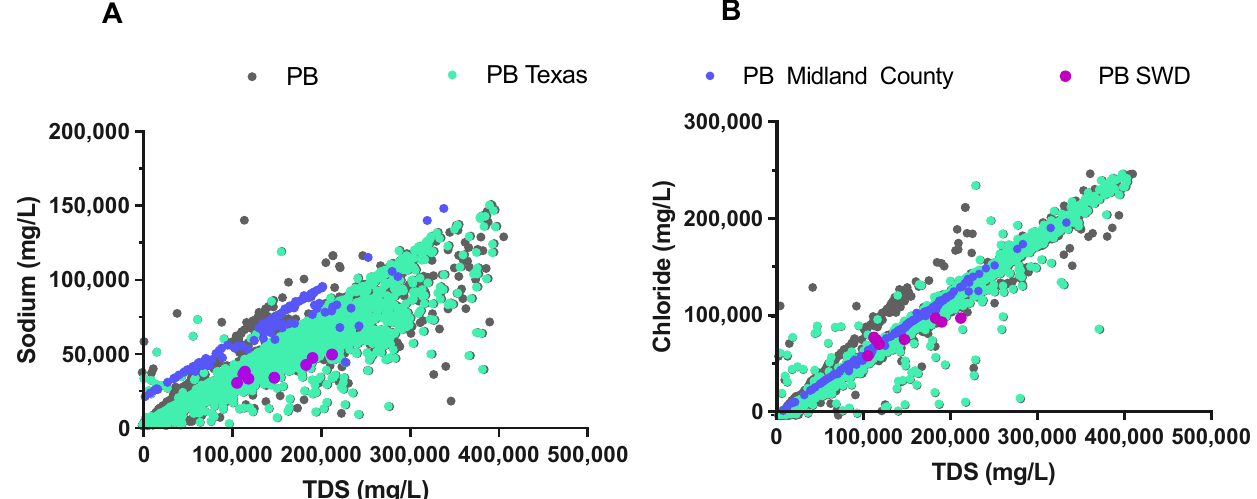
Figure 8. Correlation of ( A ) sodium and ( B ) chloride concentrations with TDS levels, plotted from conventional well PW data reported by the USGS for the PB (gray), Texas-based PB wells (cyan), production wells located in Midland County (purple), as well as the values measured for PW from UD-labeled PB SWD (magenta). The USGS’s dataset for the Permian Basin data included 16,000 samples from conventional oil and gas operations [50].